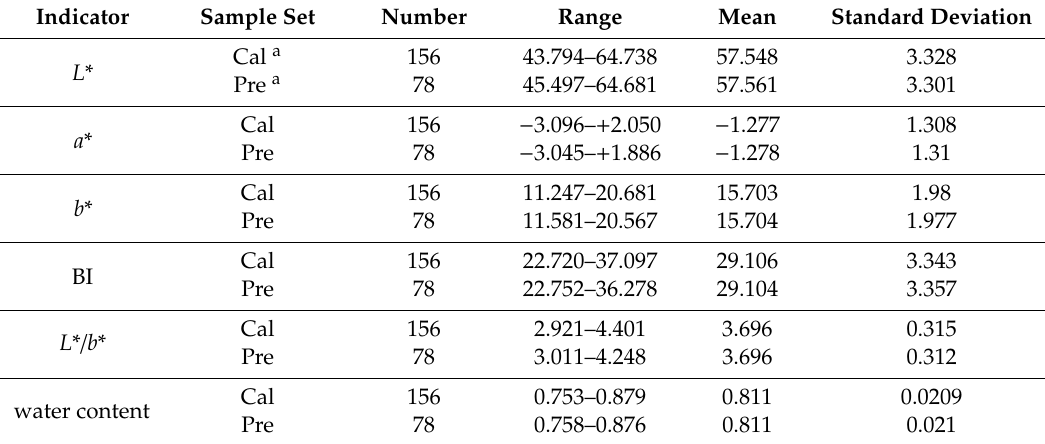
Table 1. Statistical information of potato tuber slices in the calibration and prediction sets.